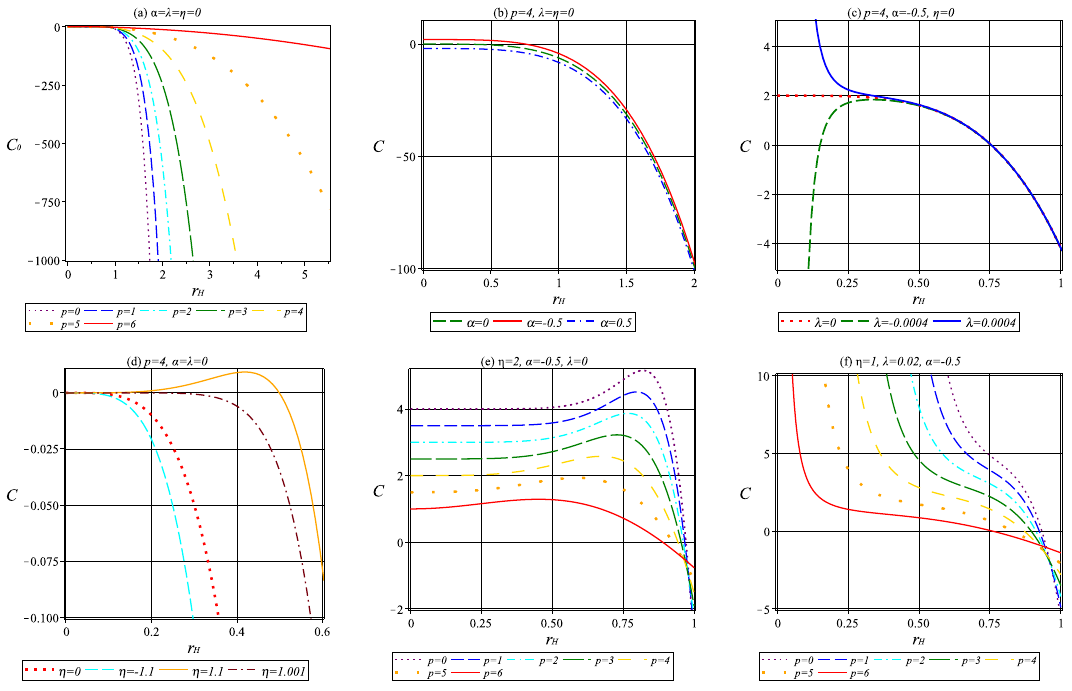
Figure 1 . Specific heat in terms of horizon radius for β = 1